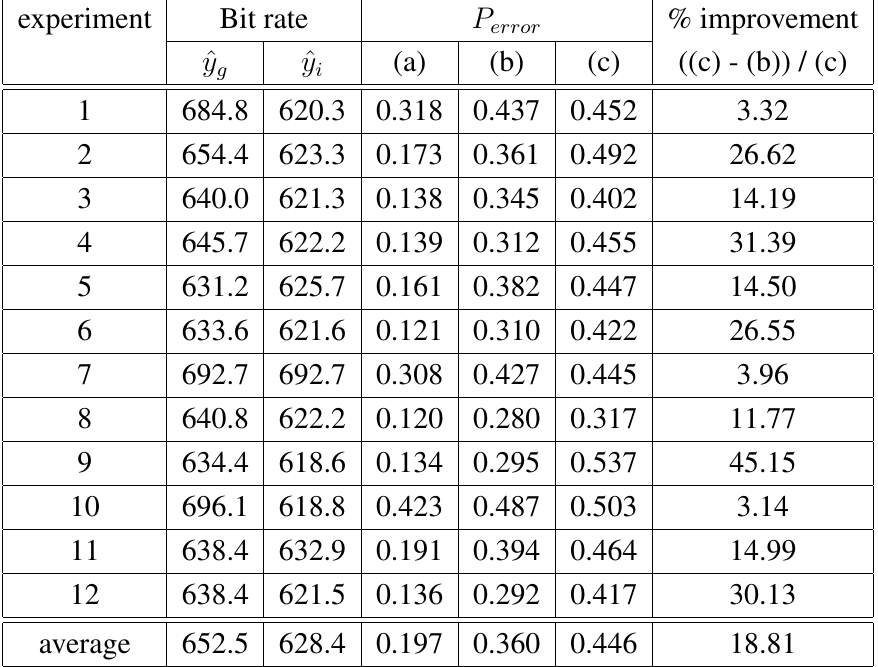
Table 3. Bit rates and estimation error of 3 filters: (a) a standard Kalman filter with uncom- pressed data, (b) the proposed method with ˆ y and ˆ y g